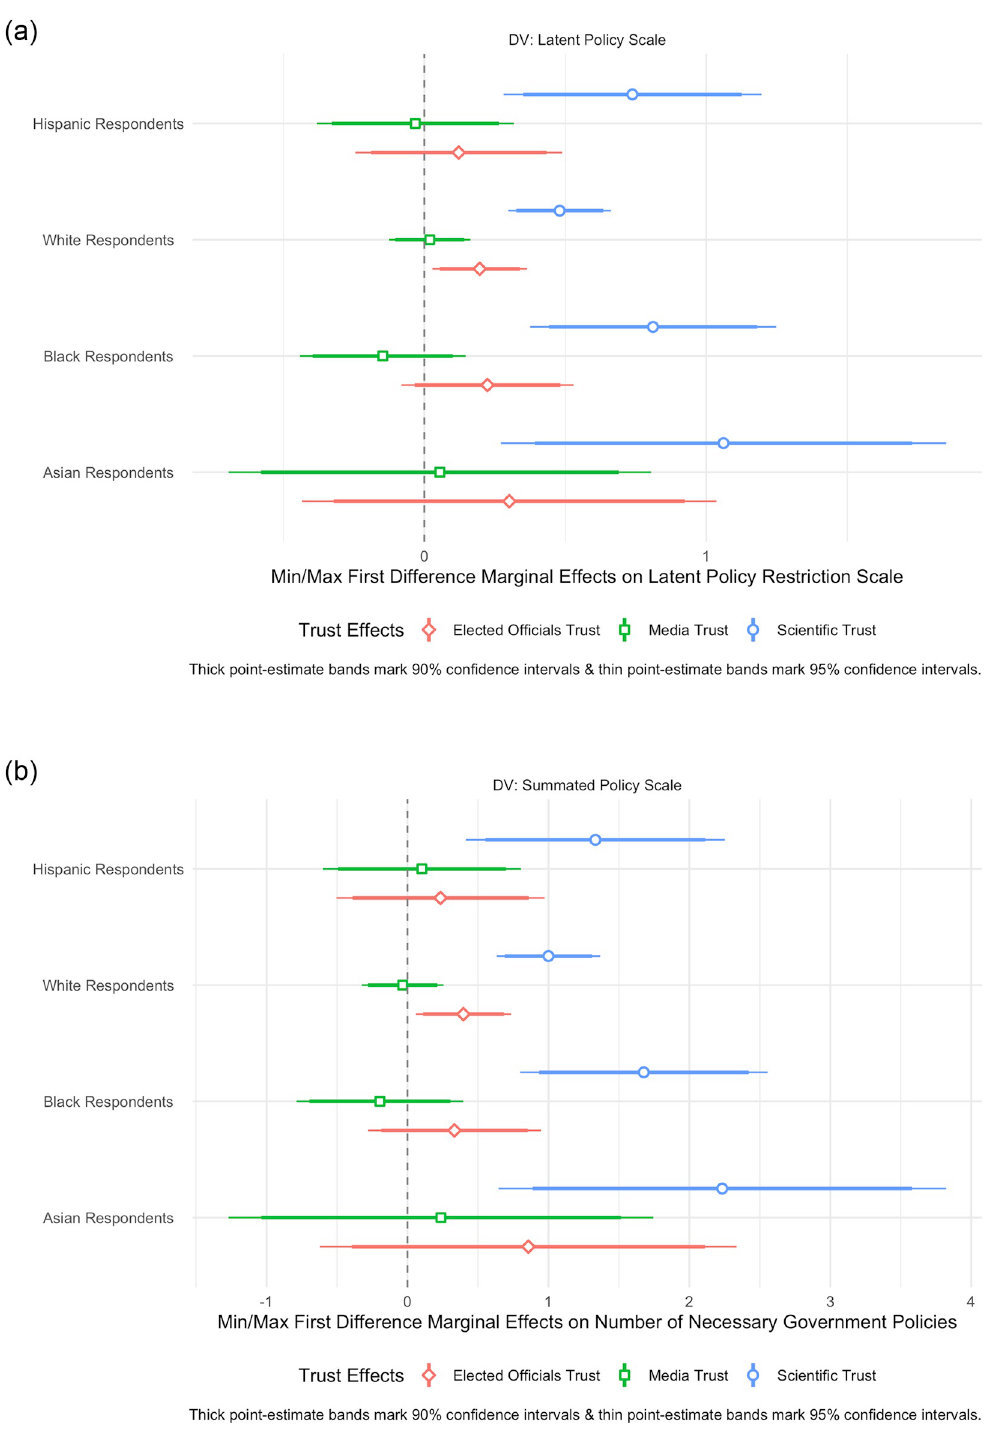
Fig 6. Baseline OLS model effects of scientific, media, & institutional trust on composite COVID-19 restriction policy support across race. A: Latent policy measure. B: Summated policy support.